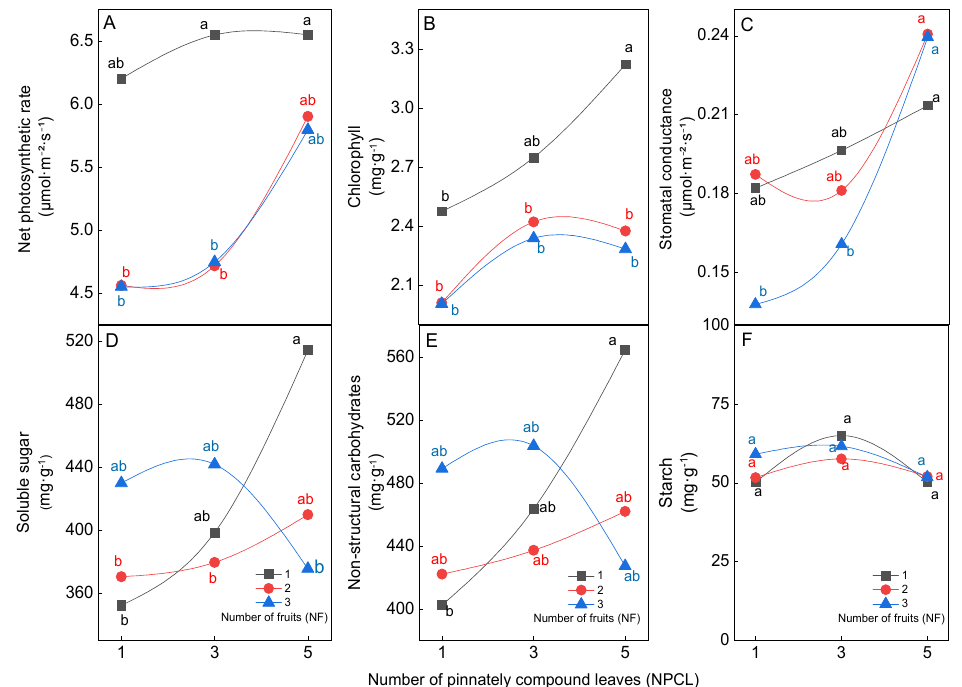
Figure 5. Effects of the source–sink relationship on walnut leaves. Different lowercase letters indicate significant ( p < 0.05) differences between branches with different leaf-to-fruit ratios.